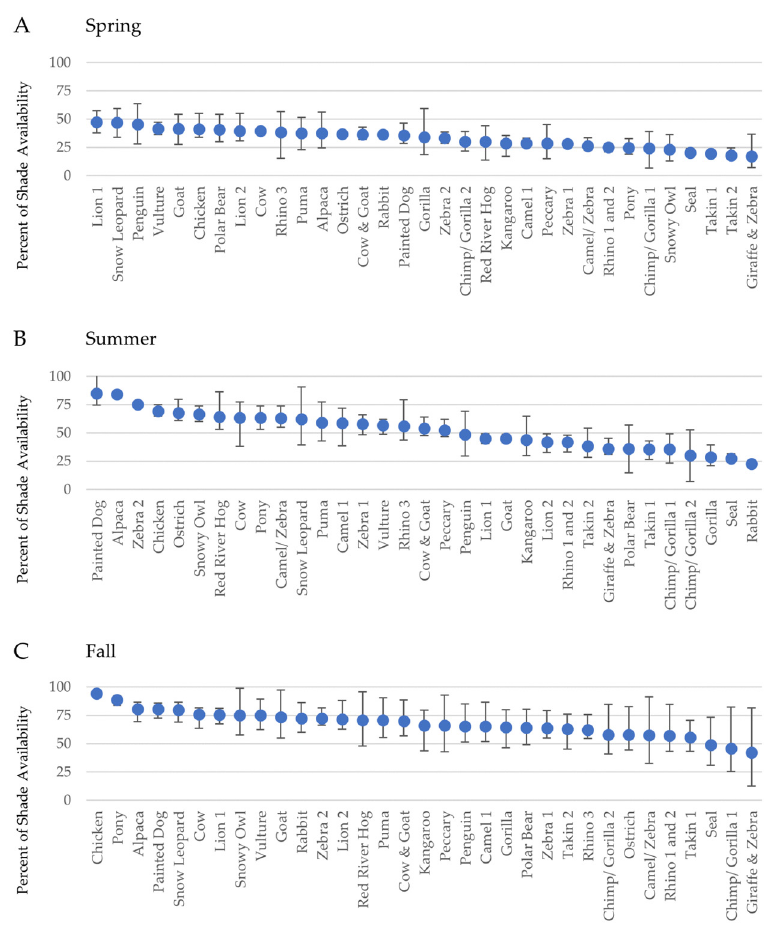
Figure 2. The average percent of shade availability in outdoor enclosures at Lincoln Park Zoo across the year. Error bars represent the minimum and maximum amount of shade available across three daily timepoints when shade was estimated (i.e., morning, midday, afternoon). Enclosures are arranged along the x -axis from most to least shade availability to demonstrate between-enclosure variability in shade availability; note the change in order between panels.